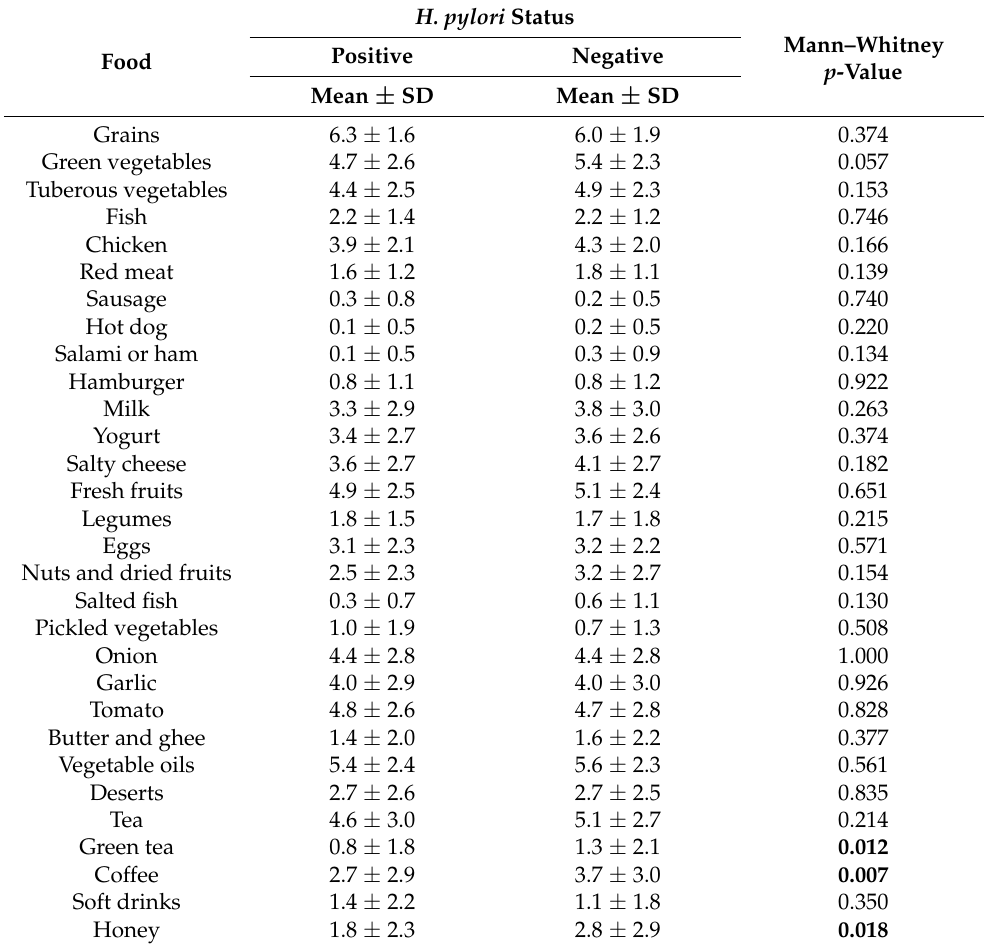
Table 3. Mean level of frequency of consumption of food and beverage items and their association with H. pylori status.